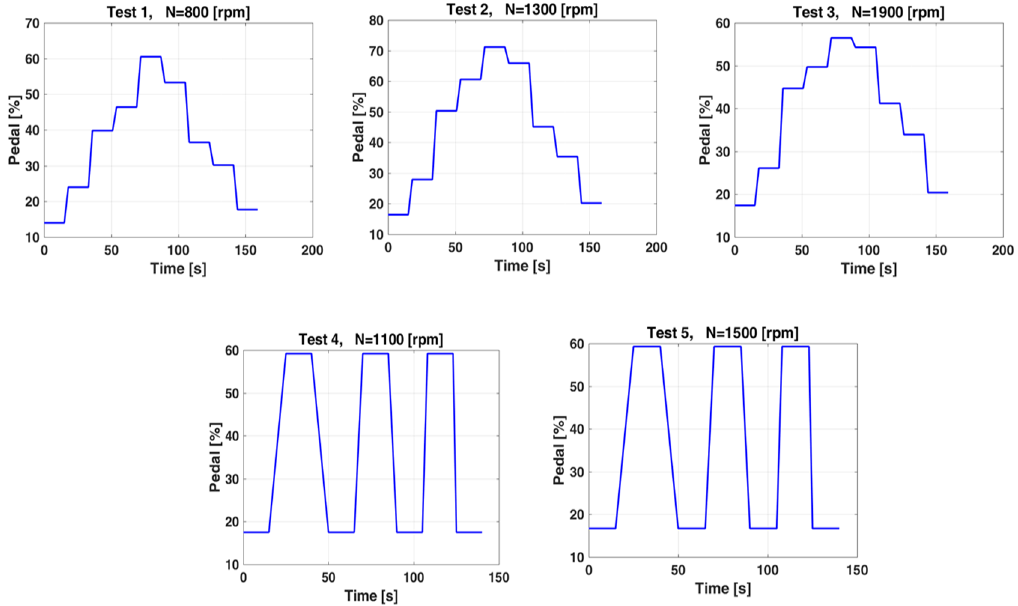
Figure 4. Time histories of the accelerator-pedal position for the different ramps acquired at different speeds for the 11L diesel engine.